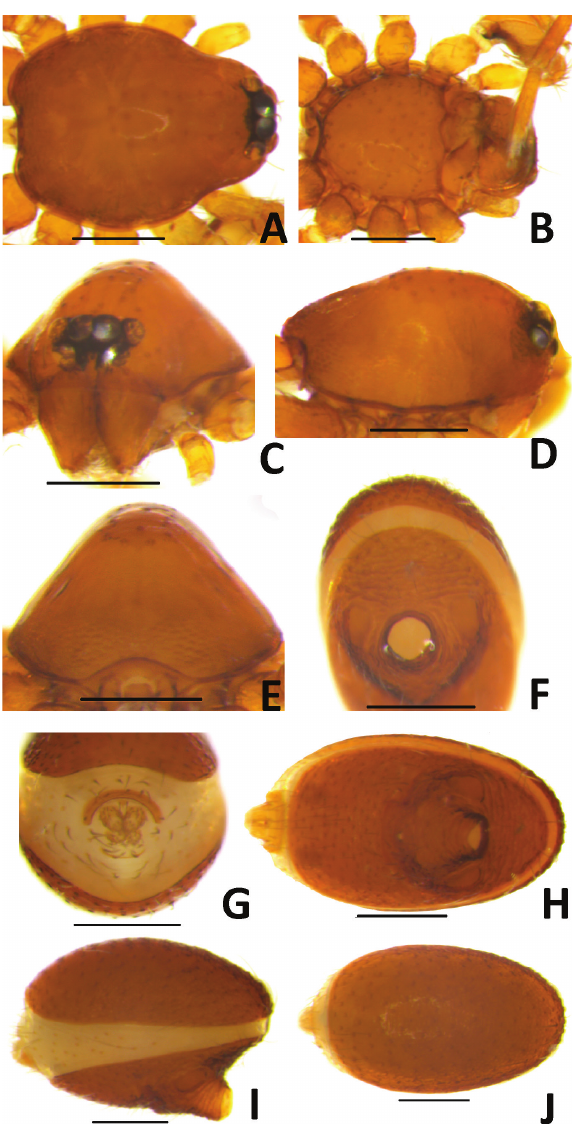
Figure 11. Pelicinus snooky n. sp., male from Ethagala FR: A , carapace, dorsal view; B , sternum, ventral view; C , carapace, anterior view; D , same, lateral view; E , same, posterior view; F , abdomen, anterior view; G , same, posterior view; H , same, ventral view; I , same, lateral view; J , same, dorsal view. Scale bars: 0.2 mm.